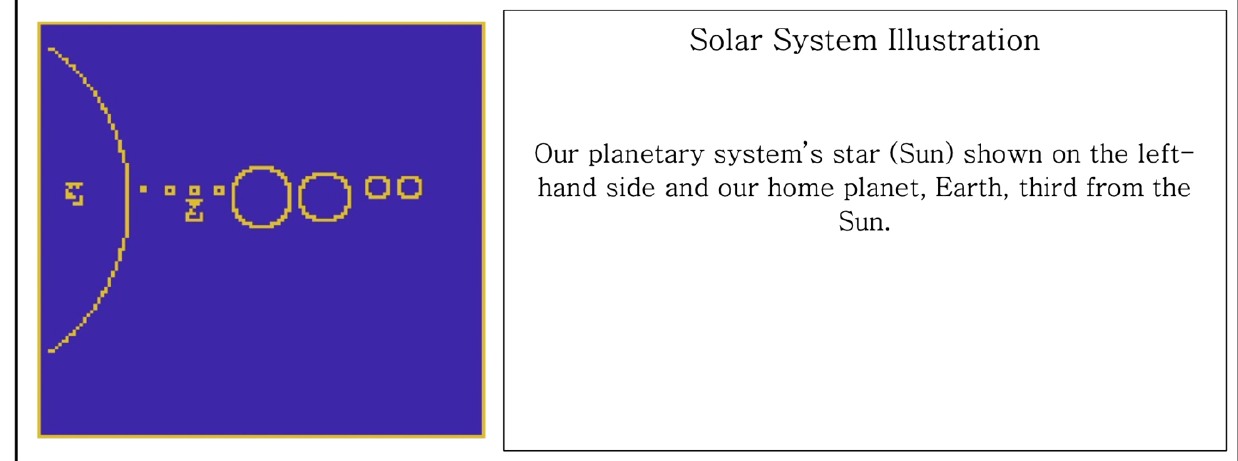
Figure 15. Pictural representation of Solar System with indicator to Earth in the Message, Page 9. In the same vein of thought, the next page of the message contains a map of the Earth.